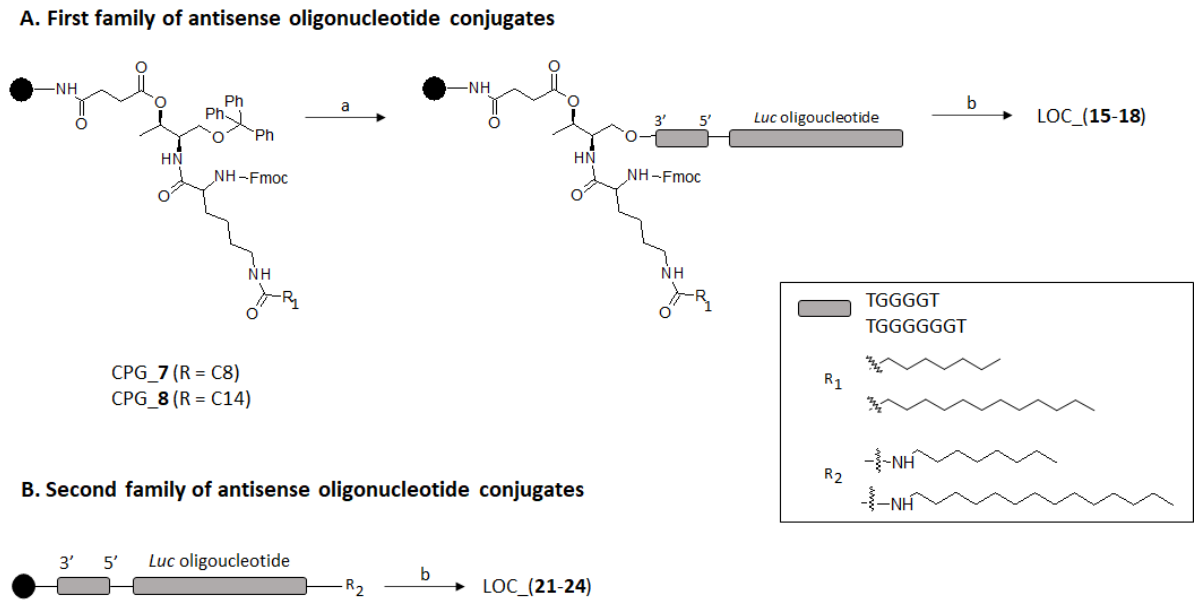
Figure 3. Preparation of (i) LOC containing threoninol-based hydrocarbon alkyl chains and a Luc oligonucleotide at the 3 (cid:48) - and 5 (cid:48) -termini of a G-rich oligonucleotide sequence (TG 4 T and TG 6 T), respectively (Group A ); (ii) LOC containing a Luc oligonucleotide at the 5 (cid:48) -termini of a G-rich oligonucleotide sequence (TG 4 T and TG 6 T) and two hydrocarbon alkyl chains at the 5 (cid:48) -termini of a Luc oligonucleotide (Group B ). Reagents and conditions: a. DNA synthesis and amide formation (5 (cid:48) -modification only); b. (i) aq. NH 3 (32%), 55 ◦ C, overnight; (ii) HPLC purification; (iii) AcOH 80%, 30 min, r.t.; (iv)